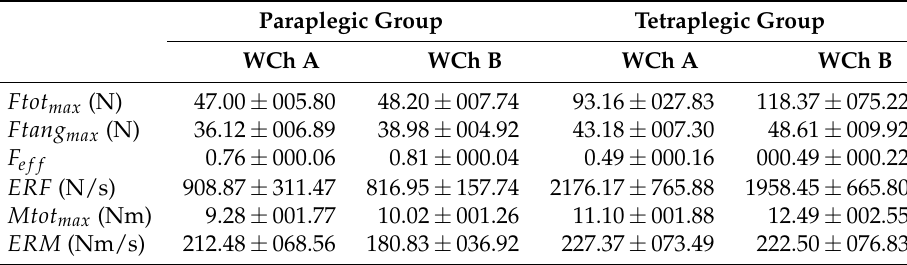
Table 7. Kinetic variables in the hand-rim (mean ± SD).